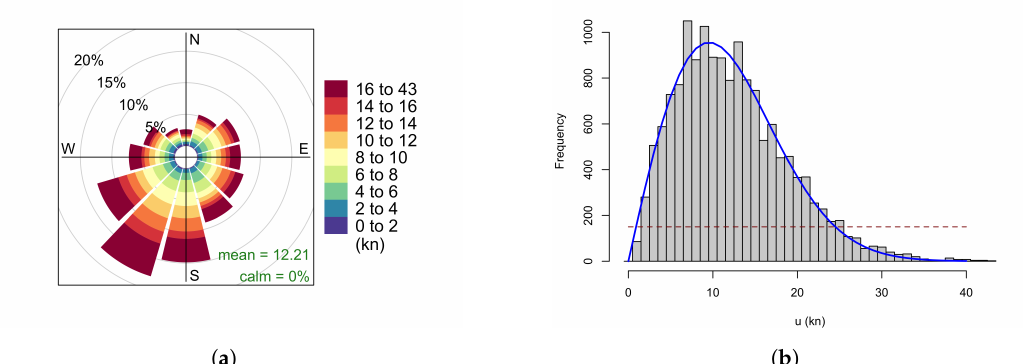
Figure 2. Wind climate during the training period, with ( a ) the wind rose at the anemometer site and ( b ) the number of samples observed in each wind speed bin (wind speeds in knots ) together with the best-fit Weibull curve (red line). The horizontal dashed line indicates 1% of the total number of